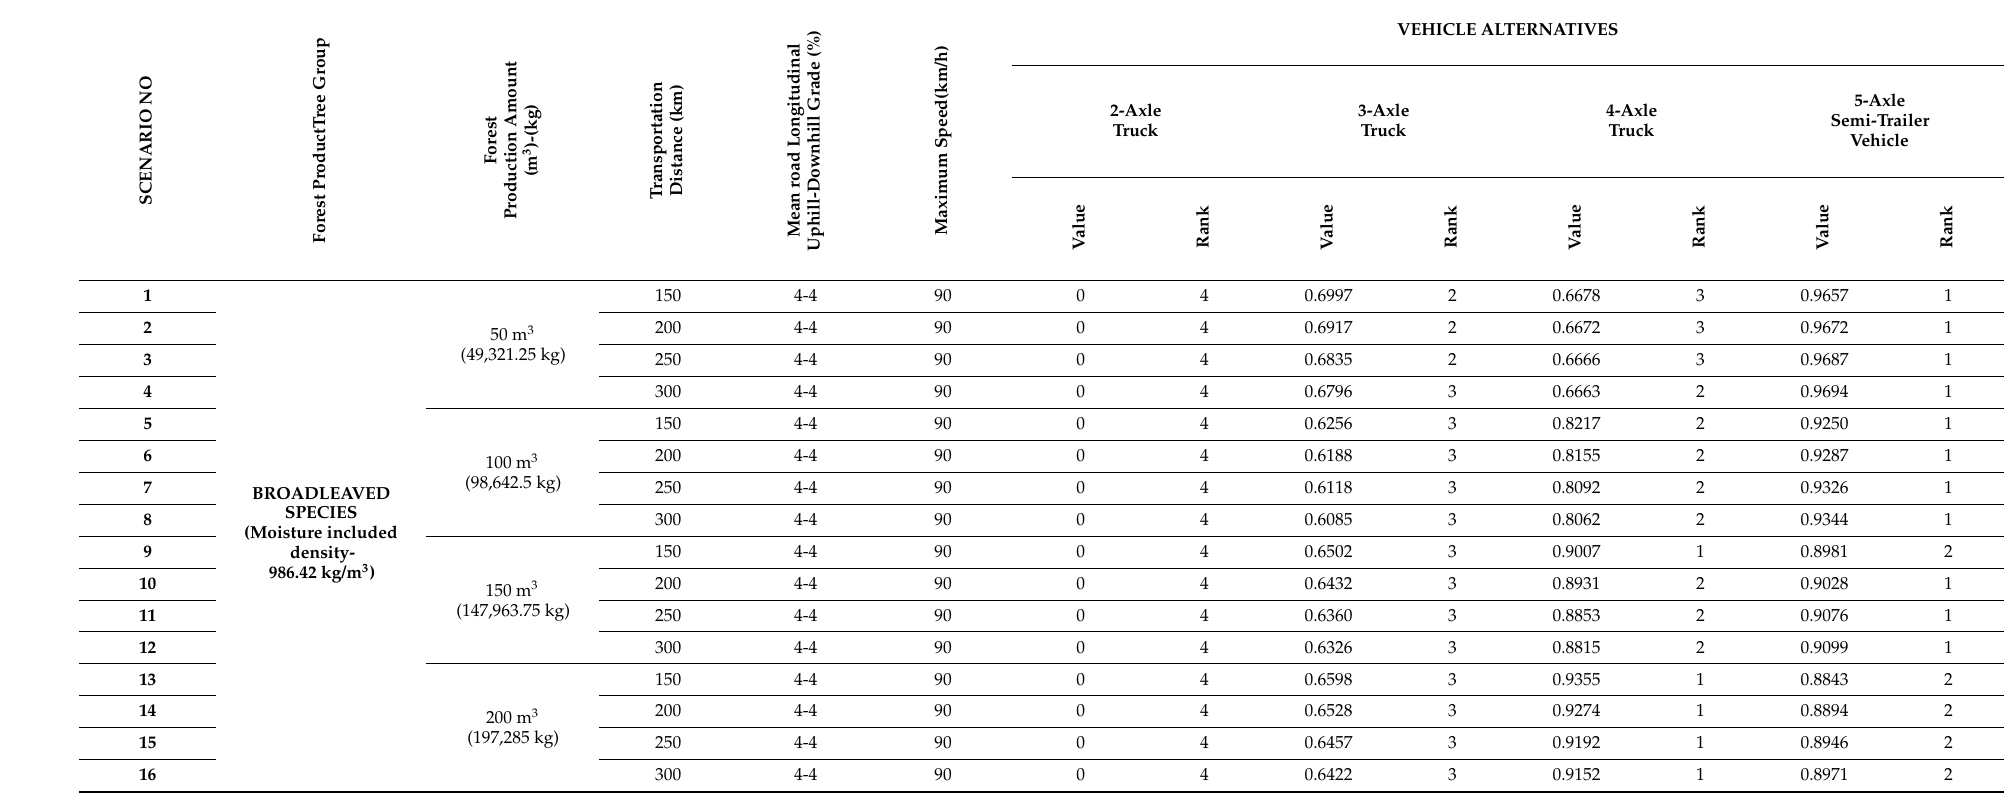
Table 24. The ranking of the vehicle alternatives according to the transportation scenarios for broadleaved tree